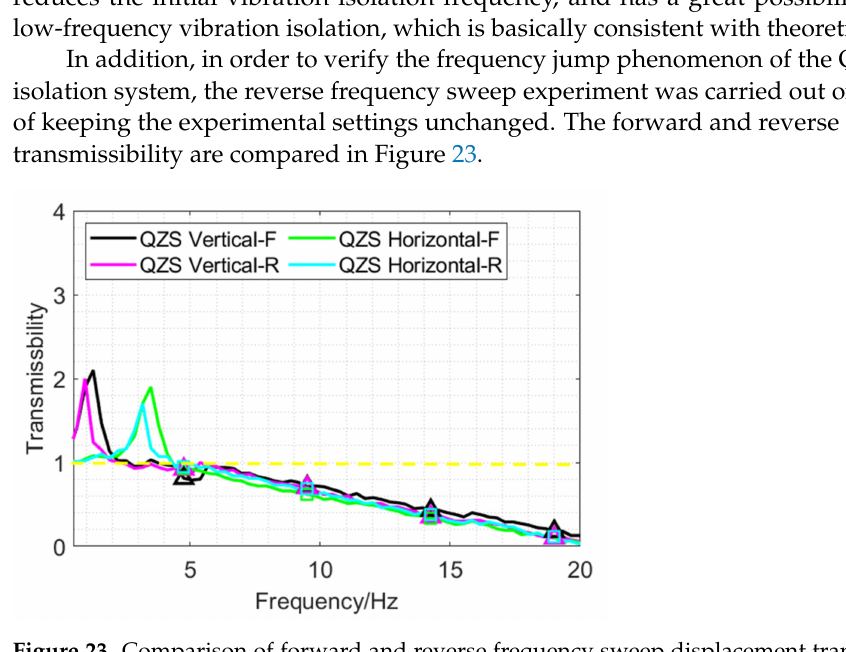
Figure 23. Comparison of forward and reverse frequency sweep displacement transmissibility of QZS